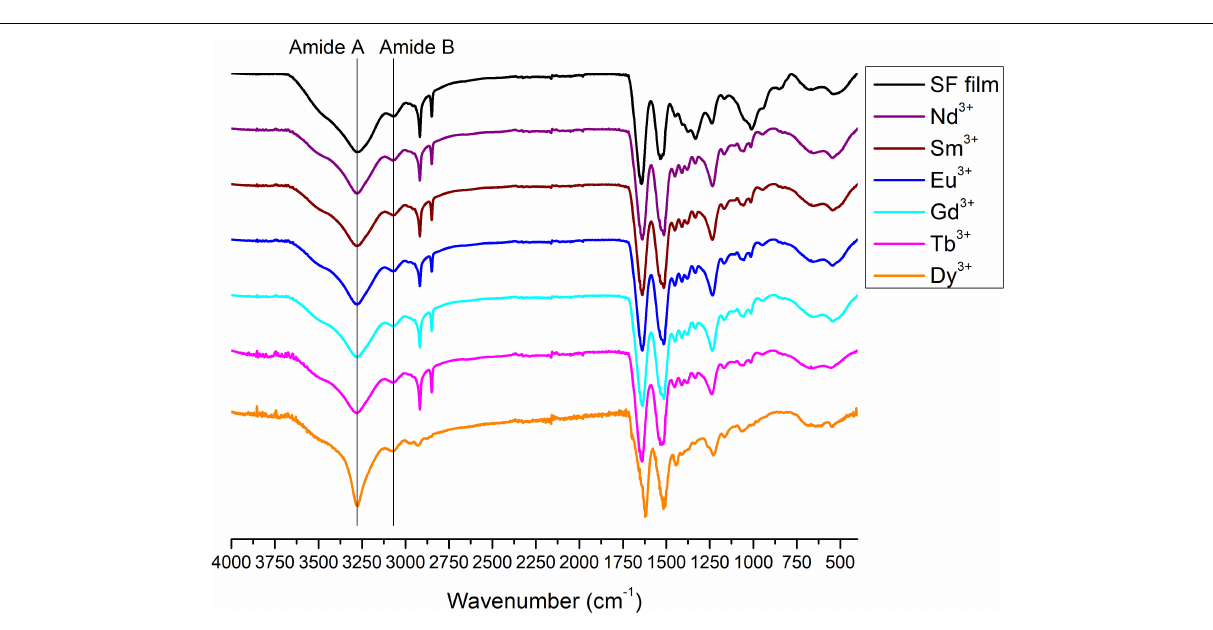
FIGURE 9 | ATR-FTIR spectra of degummed SF film (black curve) and films obtained by drop-casting of solutions of SF with Nd + 3 , Sm + 3 , Eu + 3 , Gd + 3 , Tb + 3 , and Dy + 3 after purification by